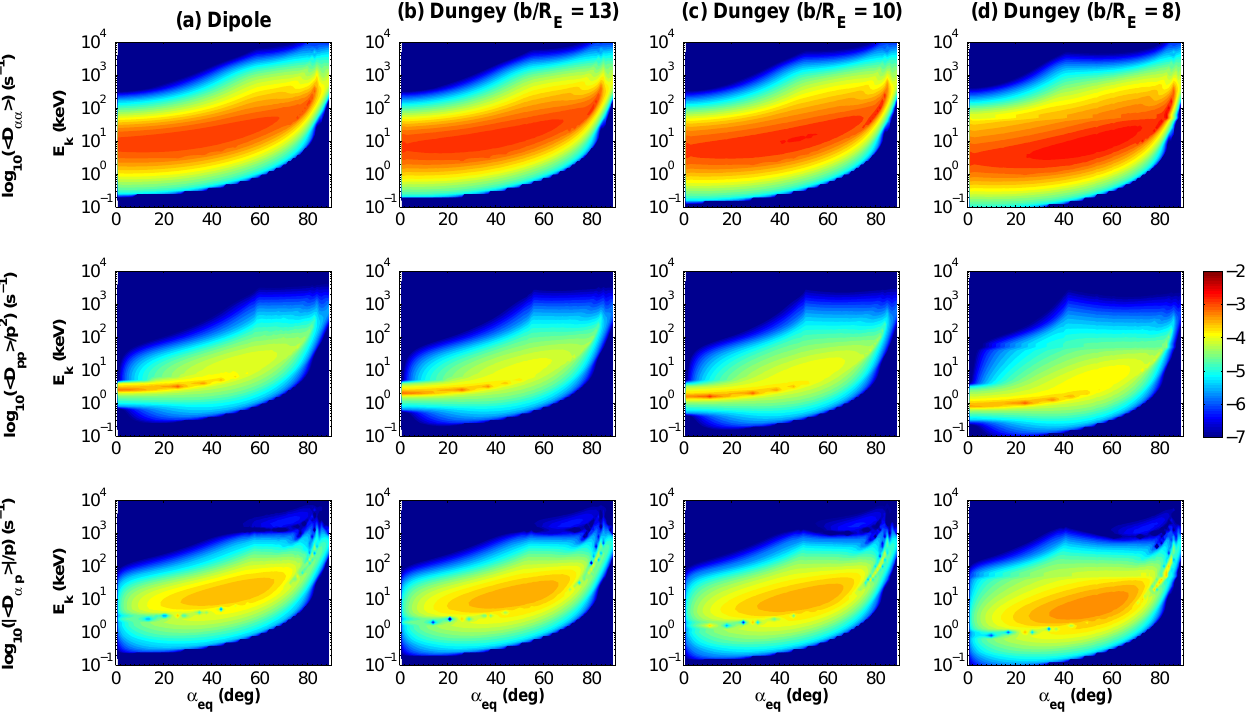
Fig. 4. Bounce-averaged diffusion rates (from top to bottom: h D αα i , (cid:10) D pp (cid:11) /p 2 and (cid:10) D αp (cid:11) /p) as a function of equatorial pitch angle α eq and electron energy E k at r 0 = 6 R E for the four Dungey magnetic fields (from left to right: b / R E = ∞ (dipole), 13, 10, and 8).